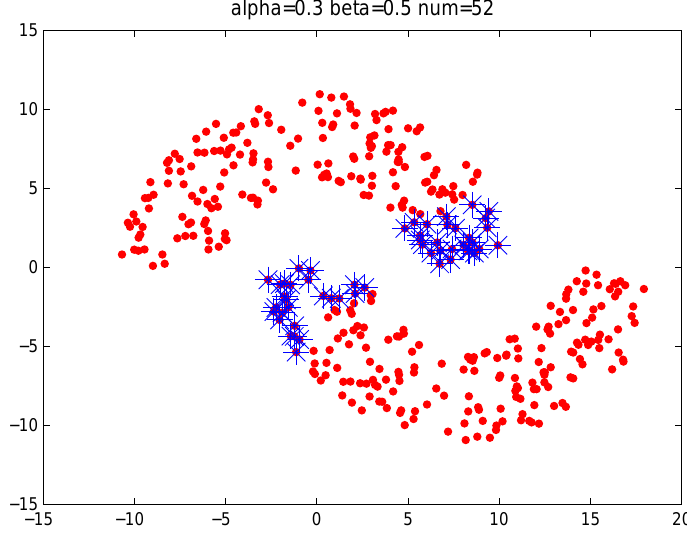
Figure 14. The “bad data points” found under α = 0.3, β = 0.5 and m =